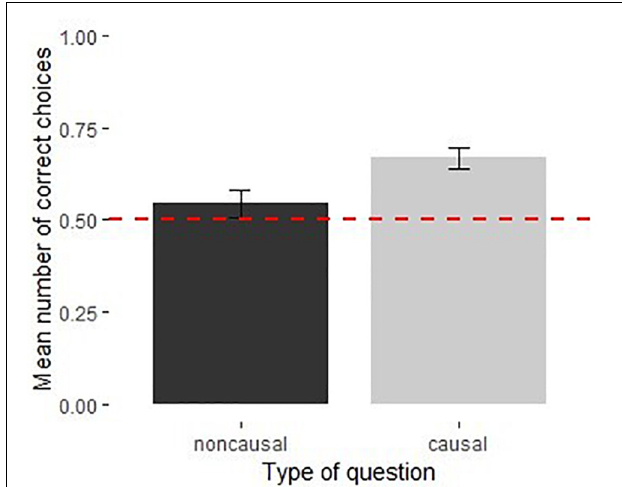
FIGURE 9 | Performance of 3-year-olds in shaken boxes when they were asked a non-causal ( N = 16, Experiment 4) vs. a causal question ( N = 28, Experiment 5). Dotted line shows chance level performance ( p = 0.05), error bars represent SE